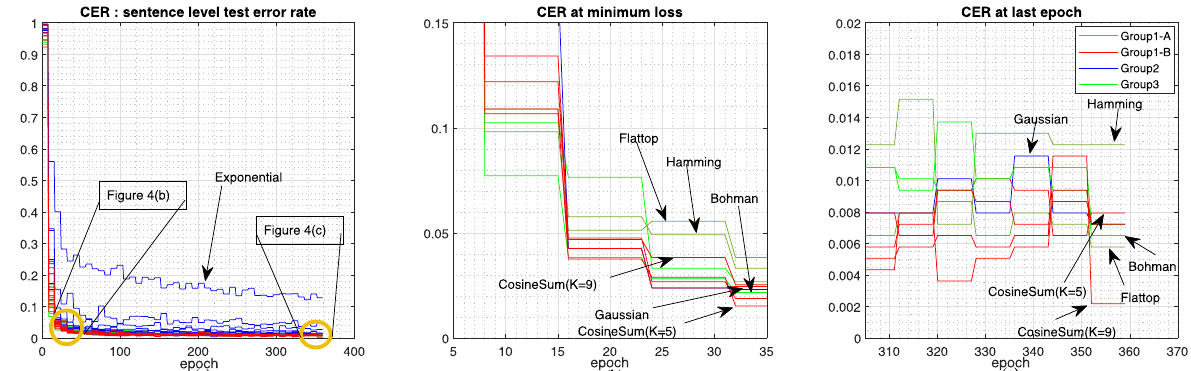
Fig. 4 a Sentence level CER for all 28 windows. b Prominent window functions at minimum loss epoch and c at last epoch. Best viewed in color and in enlarged